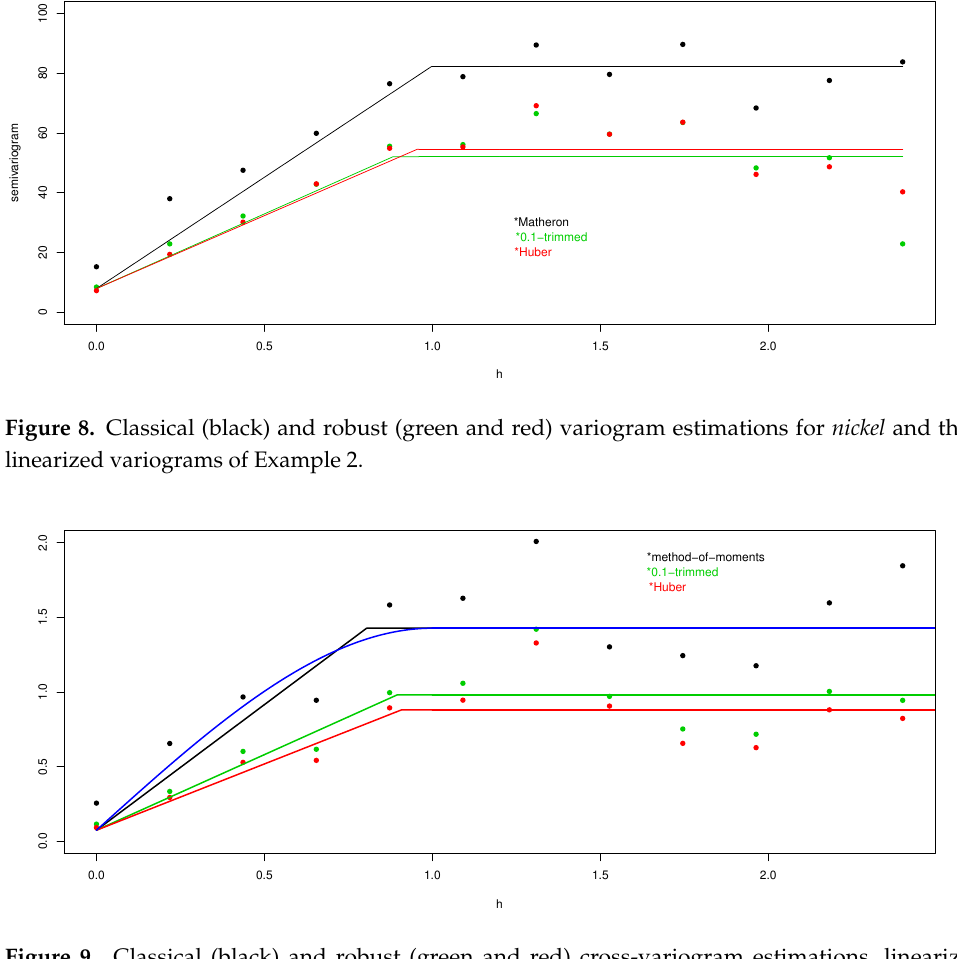
Figure 9. Classical (black) and robust (green and red) cross-variogram estimations, linearized versions, and the classical model (blue) of Example 2.